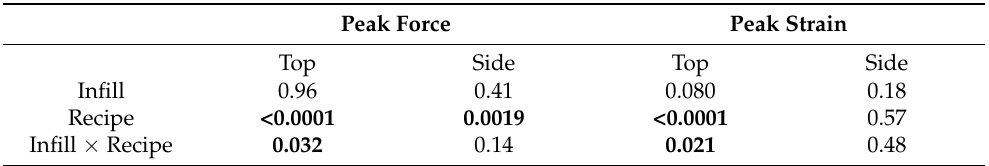
Table 5. p -values from ANOVA analysis of compression tests investigating the effect of recipe, infill pattern and their interaction. Significant values ( p < 0.05) are highlighted in